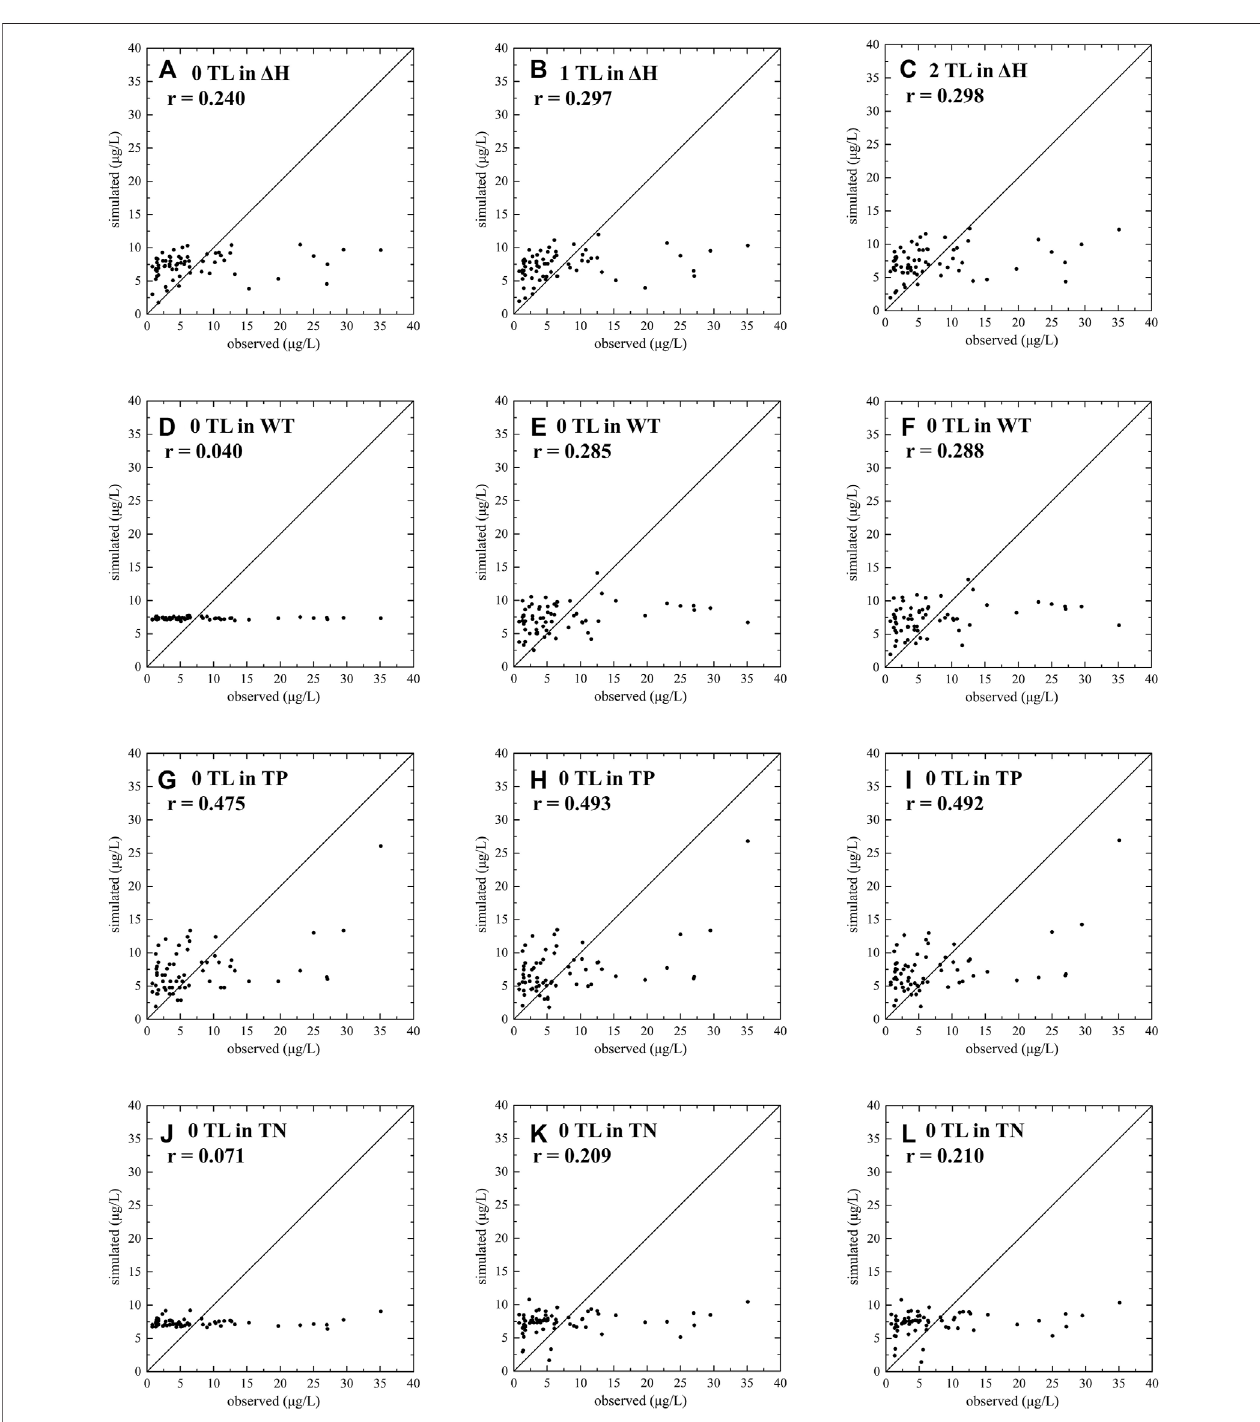
FIGURE 5 | Results of Almon Distributed Lag Model. TL, Time-lag